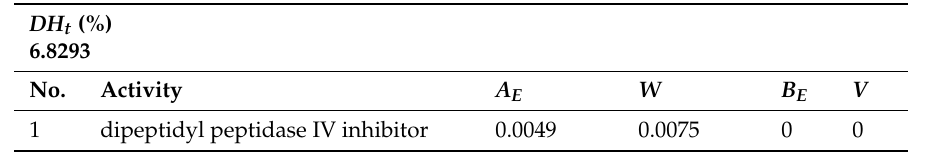
Table A12. A E , DH t , W , B E and V values from RubisCO of Halophila stipulacea . In silico enzymatic cleavage was carried out by prolyl oligopeptidase.